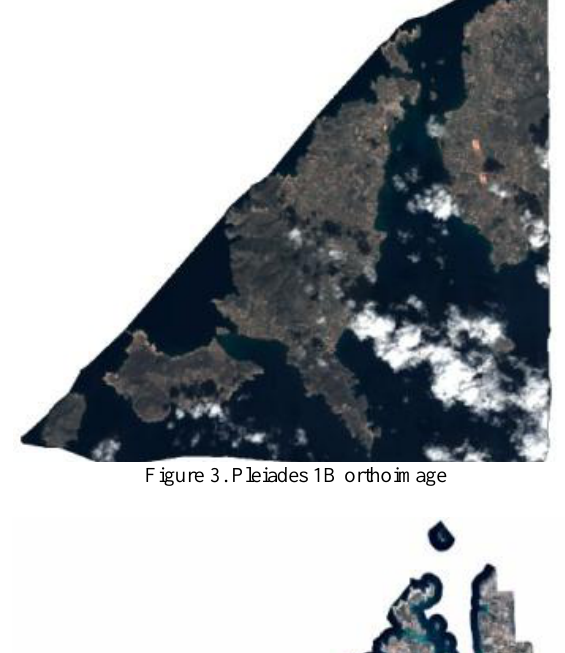
Figure 3. Pleiades 1B orthoimage